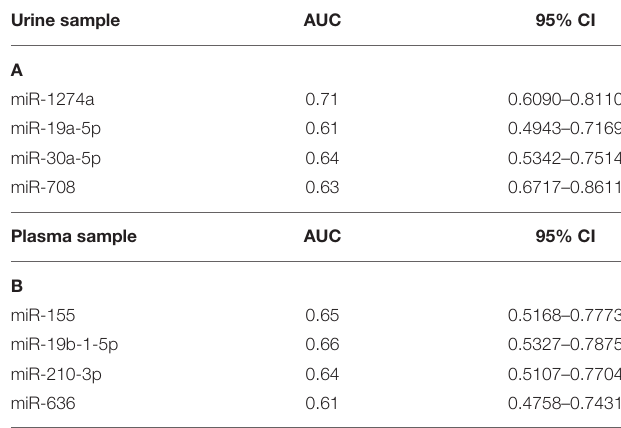
samples (B) (n = 100 and 70, respectively).